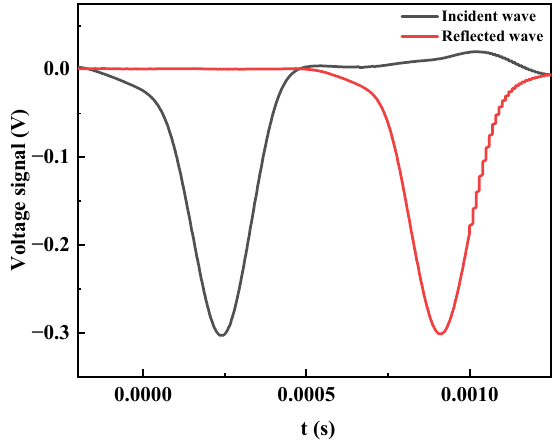
Figure 11. Recorded signal for impact with no specimens.